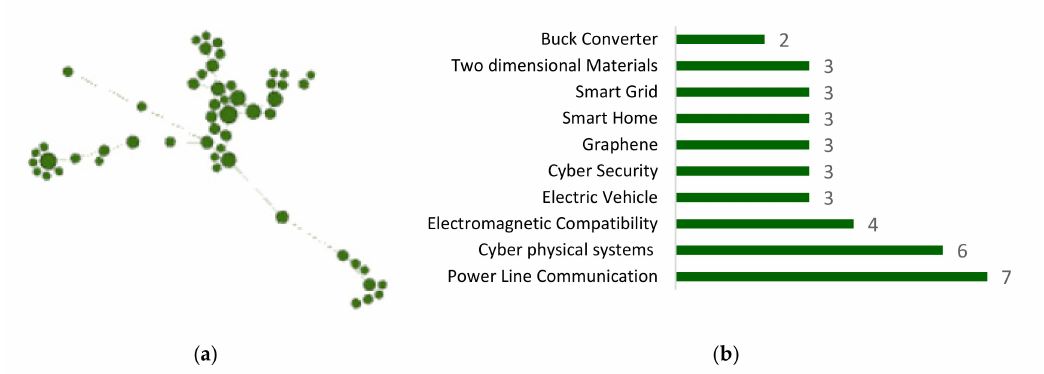
Figure19. RepresentationoftheTransmissionLinescommunity: ( a )Isolateddistributionofpublications. ( b ) Keywords of the